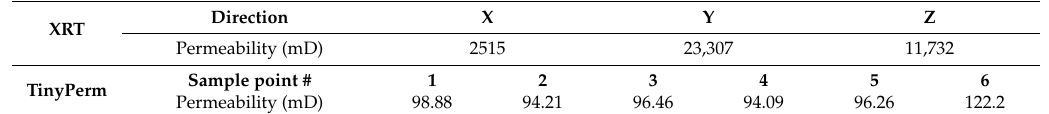
Table 2. Permeability values recorded using X-ray tomography (XRT) in the X, Y and Z directions, and TinyPerm from points 1–6 in Figure 9.